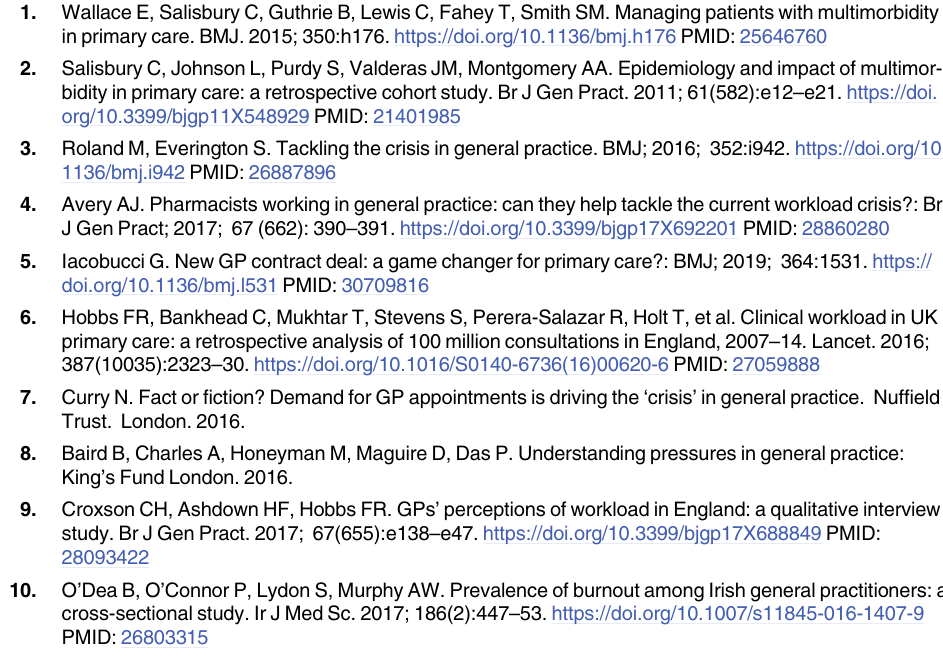
S1 Table. List of chronic